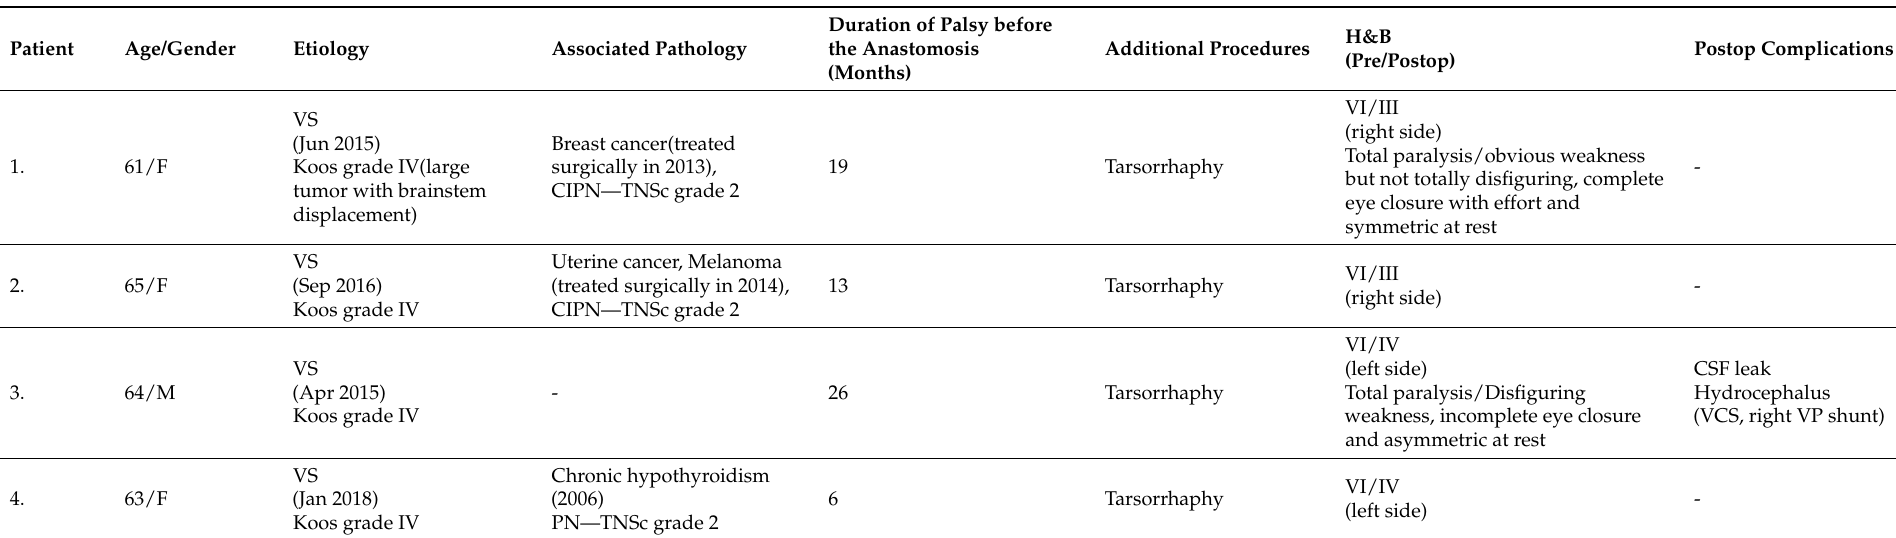
Table 1. Patient